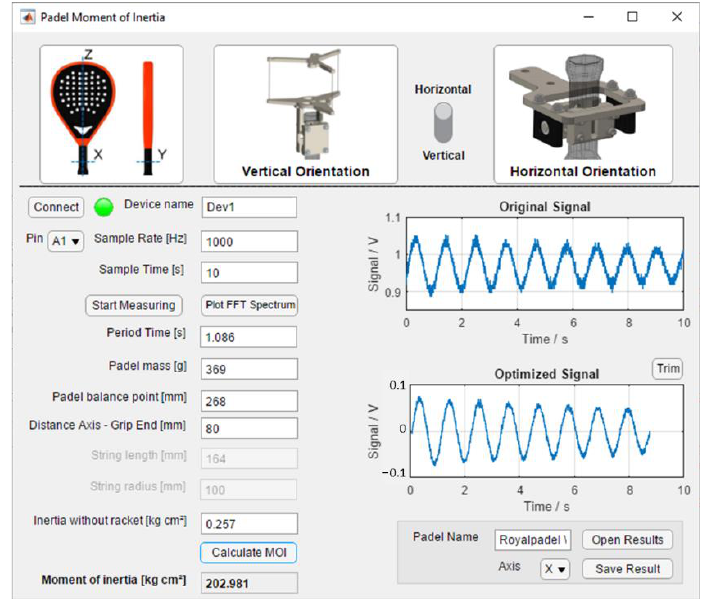
Figure 12. Screenshot of the MATLAB ® interface to run and store experiments.